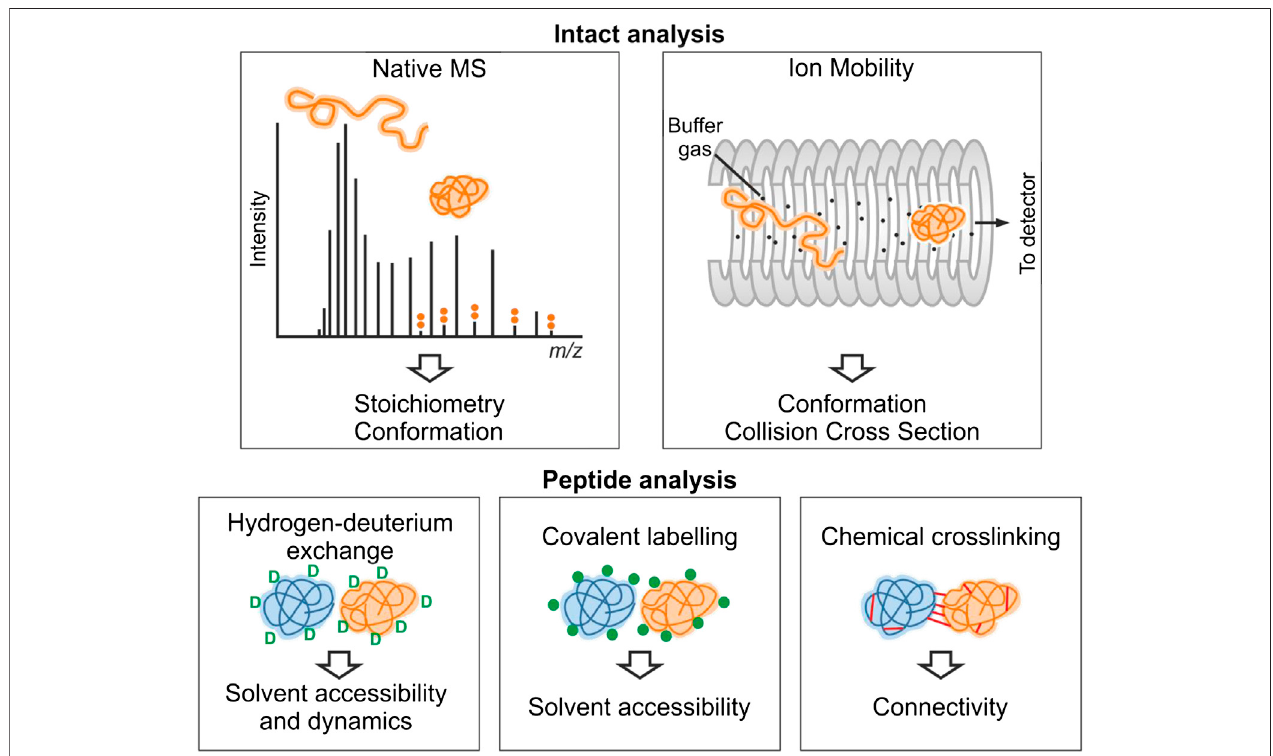
FIGURE 1 | Overview of structural mass spectrometry methods. The information obtained from each experimental method is shown. Native MS and ion mobility analyses require the protein to be analyzed by MS intact under gentle ionization conditions that preserve noncovalent interactions. For an IDP, the CSD observed by native MS typically is multimodal consistent with multiple conformational states. These conformations (e.g., collapsed and extended) can be further separated by ion mobility. In hydrogen-deuterium exchange experiments, backbone amide hydrogen atoms undergo exchange with deuterium. Covalent-labeling methods involve modi fi cation of solvent accessible side-chains with a suitable probe, and in chemical crosslinking experiments, residue pairs in close spatial proximity are joined covalently. For these three methods, the protein(s) involved are typically proteolysed, and the labels are detected by analysis of the resultant peptide fragments.